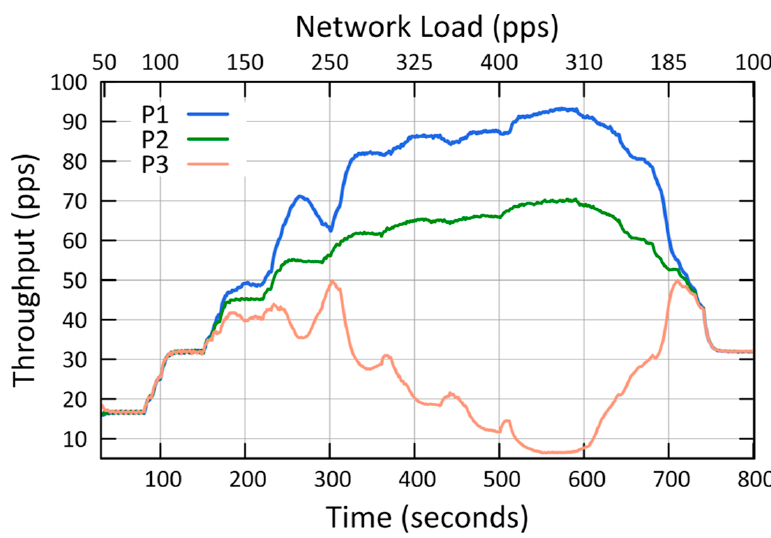
Figure 8. Packet loss (P L ) in the network.